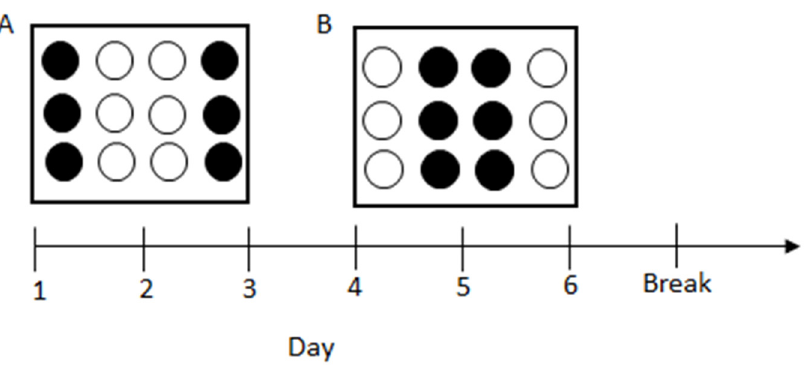
Figure 3. The two spatial patterns ( A , B ) containing rewarded wells (represented in black) during the main training. The pattern ( A ) or ( B ) that an individual experienced first was counterbalanced within each species (i.e., three parrots received pattern A first, whereas the other three parrots received pattern B first). The order of presenting the patterns was fixed for each individual across the training weeks. Each week, each parrot experienced each pattern for 3 consecutive days (3 trials per day) with a daybreak.